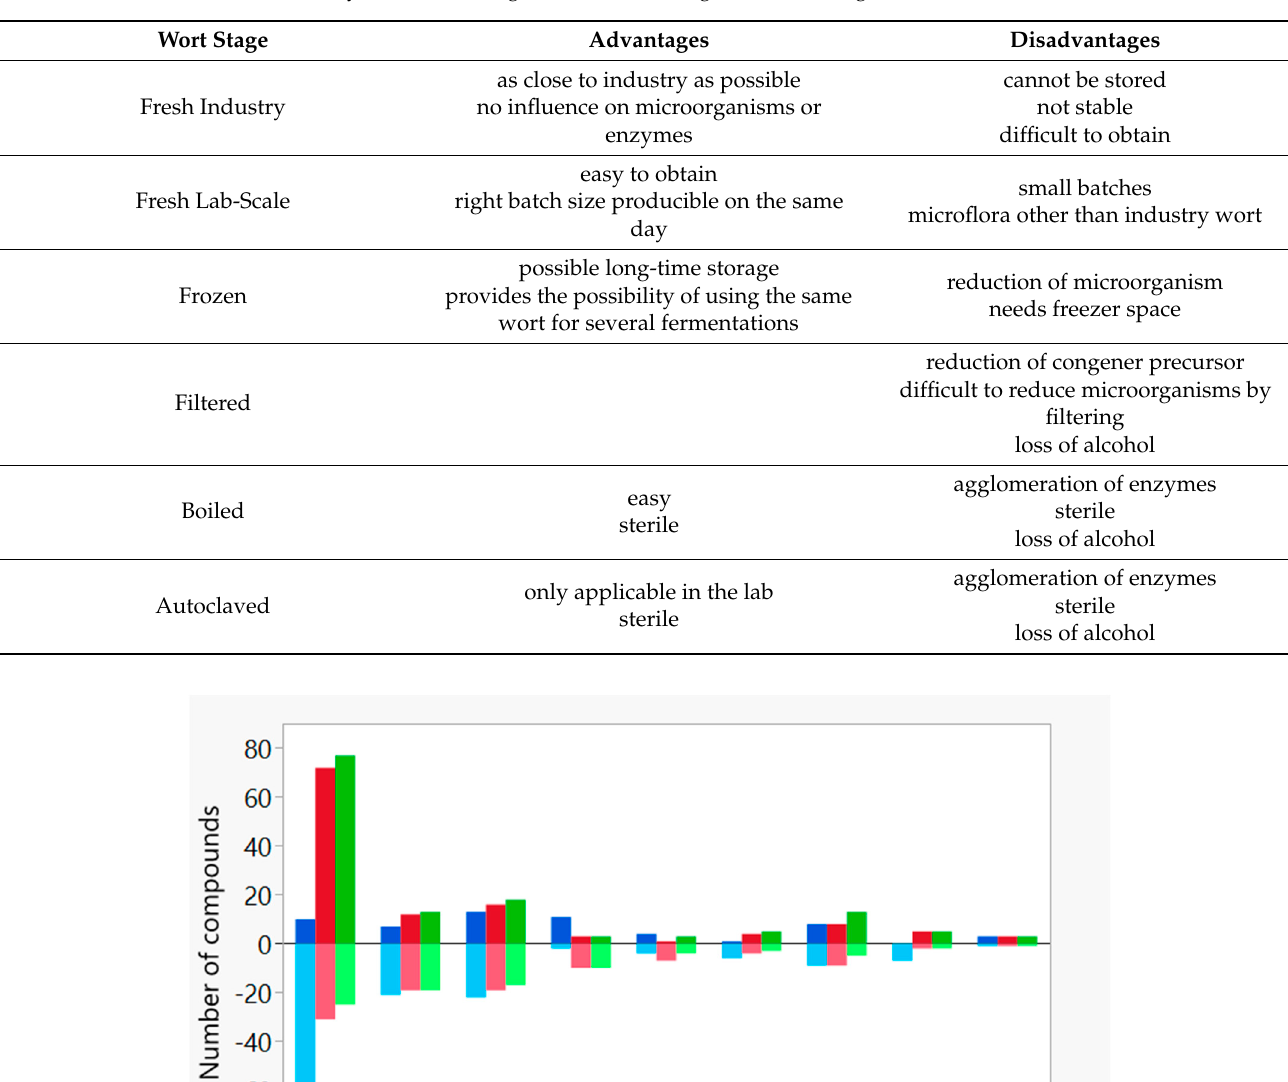
Table 2. Summary of the advantages and disadvantage of wort storage and treatment methods.